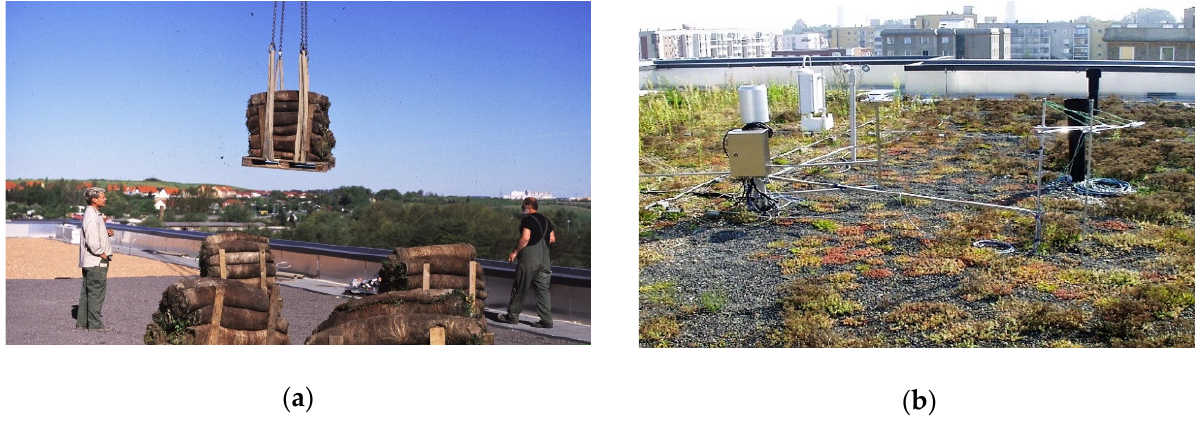
Figure 2. ( a ) Building 2, May 2001: The turf mats were placed on the north plots, as was done on the west and south plots. The growing media can be seen in the background: light red Op, dark in the front: Ulo. ( b ) Sedum cutting area on the east roof in August 2002: Right: Ulo, sedum developed slowly, left: Sedum and several spontaneously sown grasses covered the Op successfully. Maintenance work on the weather station caused some open areas in the vegetation